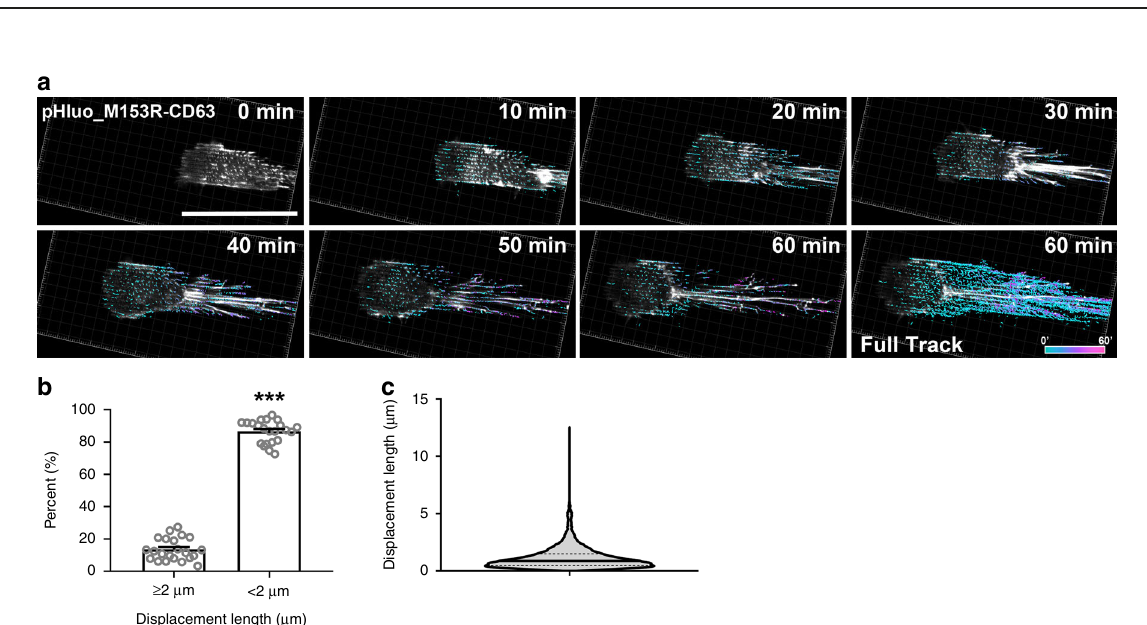
Fig. 4 Cells exhibit path fi nding behavior on exosome trails. a Time-series images from live imaging of pHluo_M153R-CD63 (green)/mCherry-CaaX (magenta) dual-expressing HT1080 cells in 2D culture conditions (see Supplementary Movie 2). mCherry-CaaX is shown in magenta and pHluo_M153R- CD63 is shown in green in the merged image. n = 186 cells from 31 movies from four independent experiments. Arrowheads indicate exosome trails. Arrows indicate protrusions. pHluo_M-CD63, pHluo_M153R-CD63. Scale bar, 50 µ m. b Path fi nding index from ( a ) shown as a scatter-plot with median and quartile range. c Time-series images from live imaging of pHluo_M153R-CD63 (green)/mCherry-CaaX (magenta) dual-expressing HT1080 cells in 3D collagen gels (see Supplementary Movie 3). n = 151 cells from 27 movies from four independent experiments. Arrowheads indicate exosome trails. Arrows indicate protrusions. Scale bar, 50 µ m. d Path fi nding index from ( c ) shown as a scatter-plot with median and quartile range. e Representative intravital images of pHluo_M153R-CD63 (green in merge) and collagen fi bers (white in merge) in mice from eight independent experiments. Multiphoton z -stacks shown as maximum intensity-projections. Arrows indicate adhesive protrusions. Arrowheads indicate exosome deposits. Examples of exosome deposits associated with collagen fi bers are shown in dotted circles. Scale bar, 50 µ m. f Representative intravital images of pHluo_M153R-CD63 in chicks from six independent experiments. Arrows indicate adhesive protrusions. Arrowheads indicate exosome deposits. Scale bar, 50 µ m. g Half-life determination of pHluo_M153R-CD63 small EVs in vivo using the avian embryo model ( n = 7 chick embryos from three independent experiments). Flow cytometry was performed on chick plasma collected at each time point upon intravenous injection of pHluo_M153R-CD63 small EVs. Gated pHluo_M153R-positive events (pHluo_M153R + ) at each time were used for half-life calculations in GraphPad Prism. The gating strategy is shown in Supplementary Fig. 4. Source data are provided as a Source Data fi le.